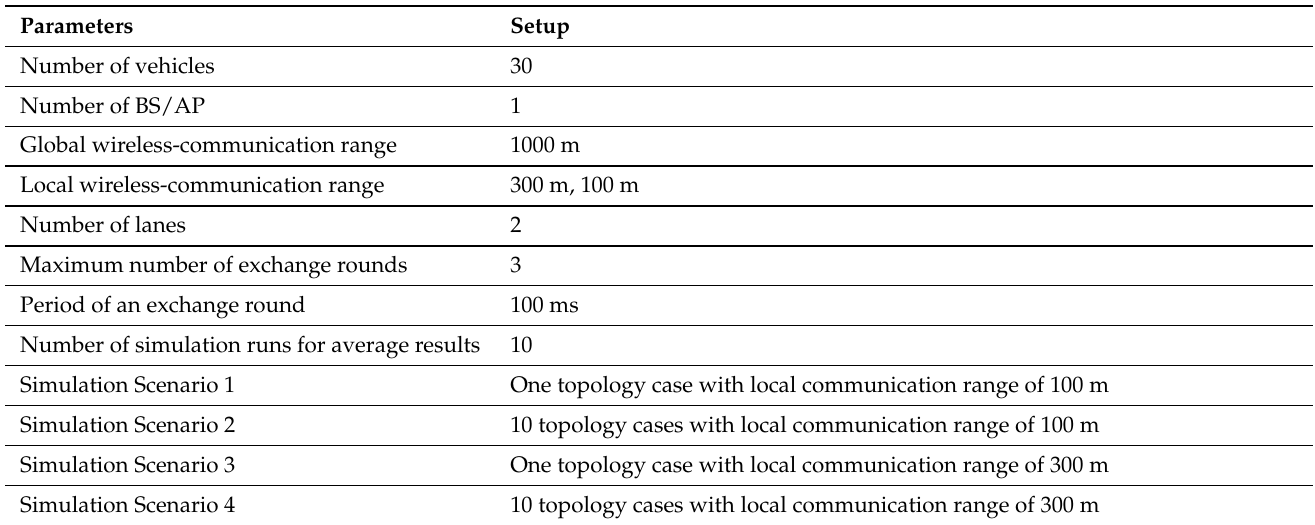
Table 1. Basic simulation setup.